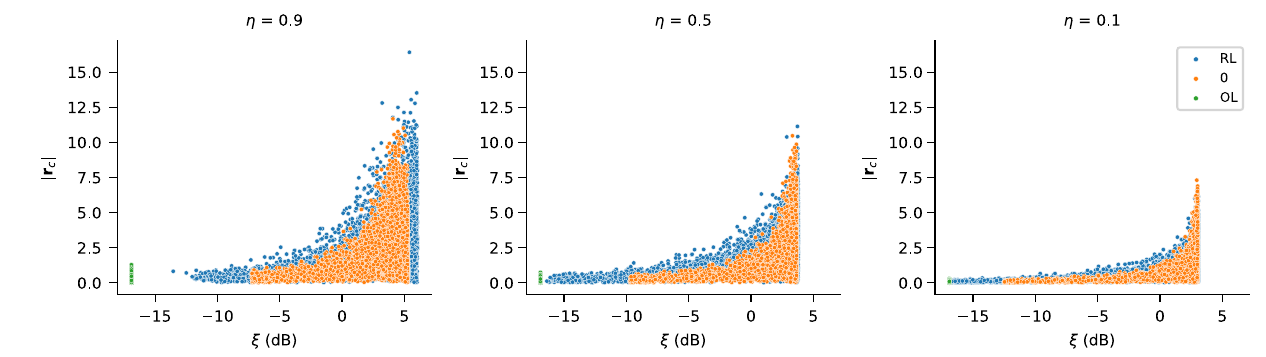
FIG. 8. Scatter plot of the squeezing (expressed in decibels) perpendicular to the conditional first-moment vector ¯ r c and the absolute value of the first-moment vector |¯ r c | for the three control strategies at time κ t = 180 and for different values of η